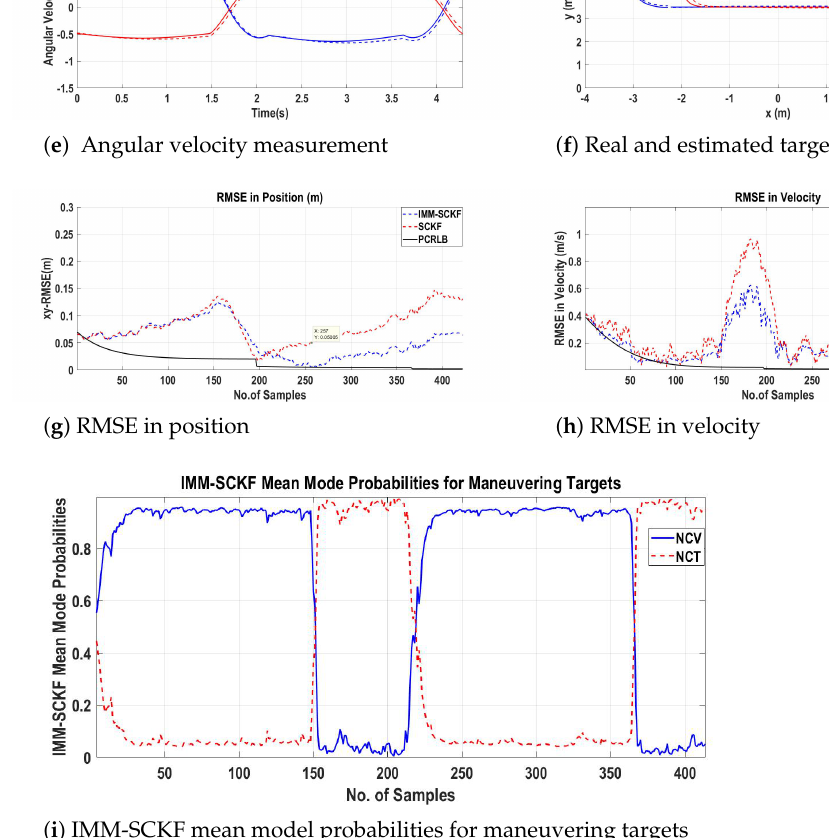
Figure 10. Scenario 3: Two maneuvering targets with crossing track